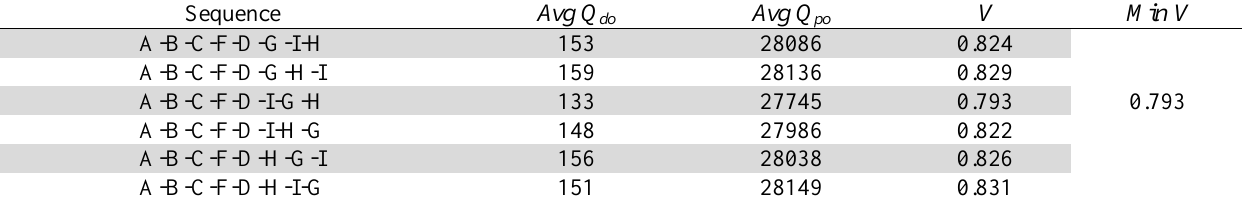
Results obtained for different